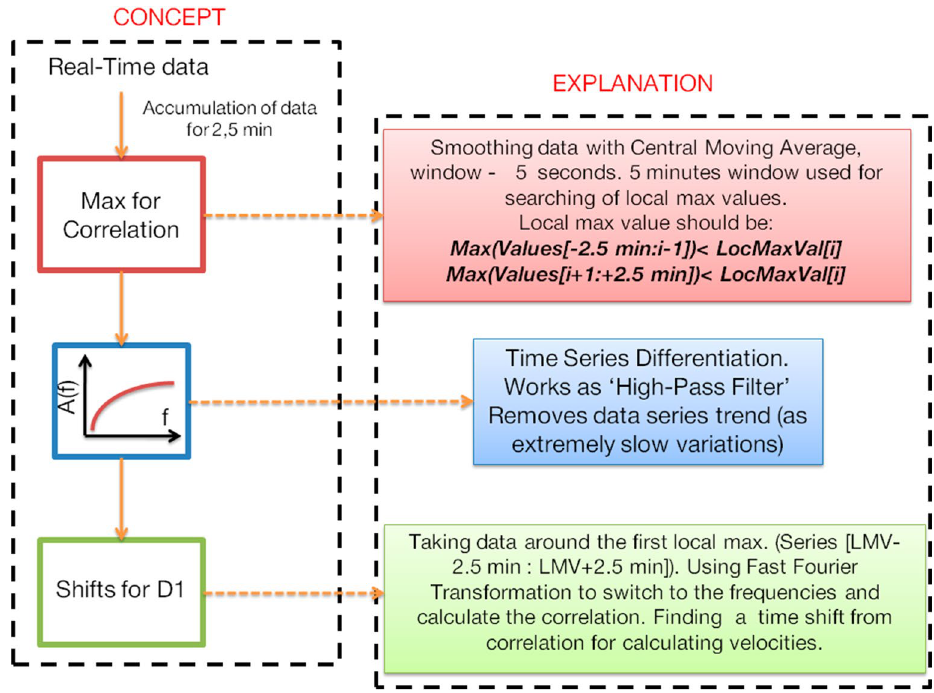
Figure 2. The concept of the near-real-time detection of CTID and TID, and explanation of the main steps of the